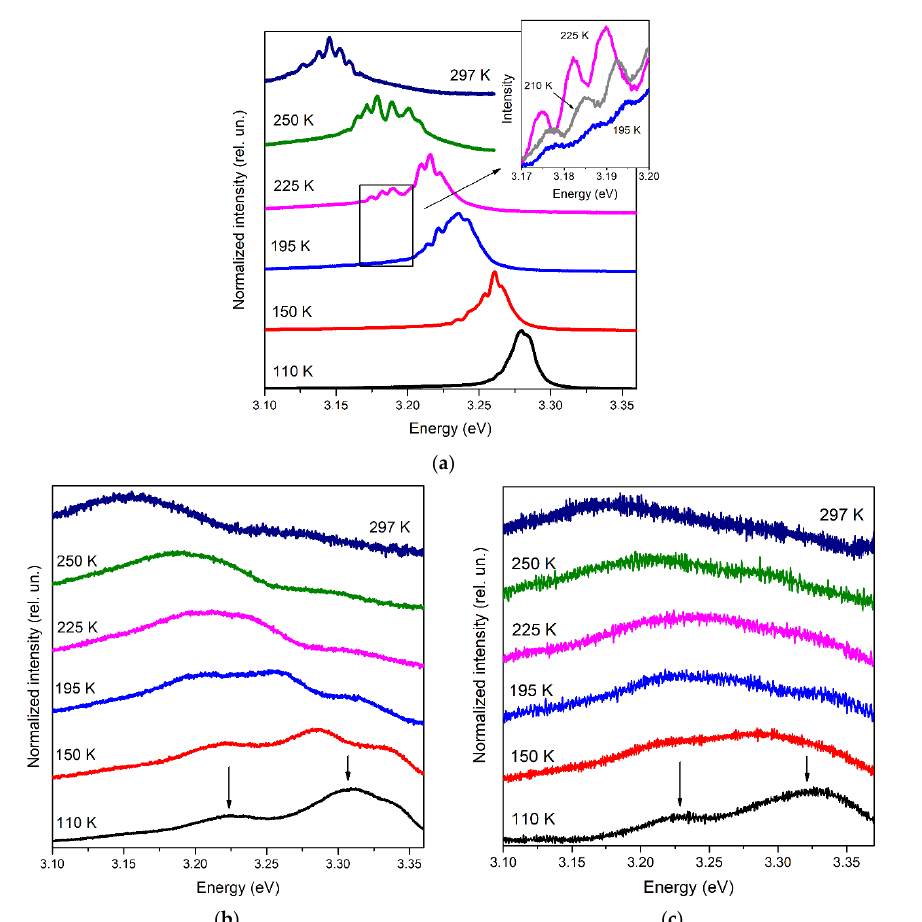
Figure 4. NBE emission spectra of the sample at different temperatures in the case of: ( a ) lasing at ρ exc = 45 kW/cm 2 ; ( b ) type I emission at ρ exc = 15 kW/cm 2 ; ( c ) type II emission at ρ exc = 6 kW/cm 2 . Spectra are normalized at maximum intensity and displaced vertically for clarity. The arrows in ( b , c ) indicate the traced bands (see the text below and Figure 5).